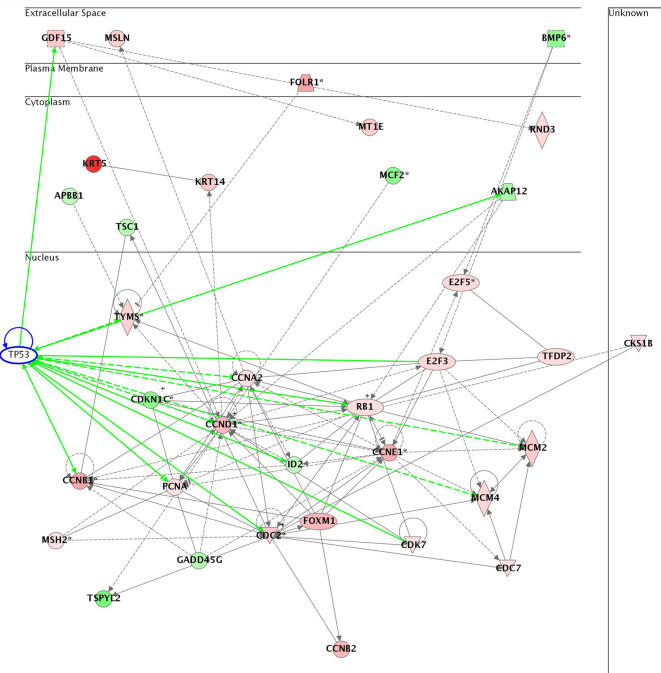
Gene interaction network of altered genes associated with cell cycle regulation and cancer as determined by Ingenuity Pathways Analysis.Genes colored red showed increased expression in carcinomas relative to adenomas and in green had decreased expression in carcinomas relative to adenomas. Increased levels of cyclin D1 (CCND1), cyclin E1 (CCNE1), cyclin B1 (CCNB1), cyclin B2 (CCNB2), cyclin A2 (CCNA2), E2F3, E2F5, cyclin-dependent kinases (CDC2 and CDK7) as well as decreased levels of p57 cyclin-dependent kinase inhibitor (CDKN1C) and growth arrest and DNA-damage-inducible, gamma (GADD45G) are all consistent with carcinomas having higher proliferation rates than adenomas. Interactions of these genes with p53 are highlighted as green lines.